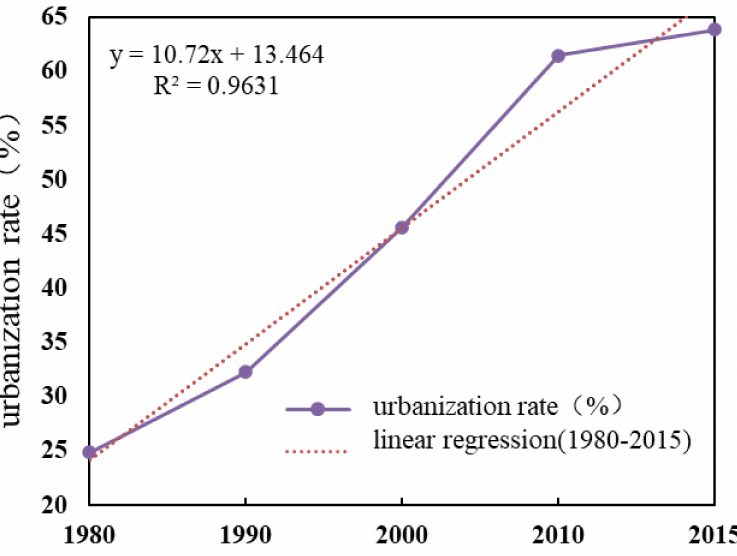
Figure 10. Change in the urbanization rate of Xilingol from 1980 to